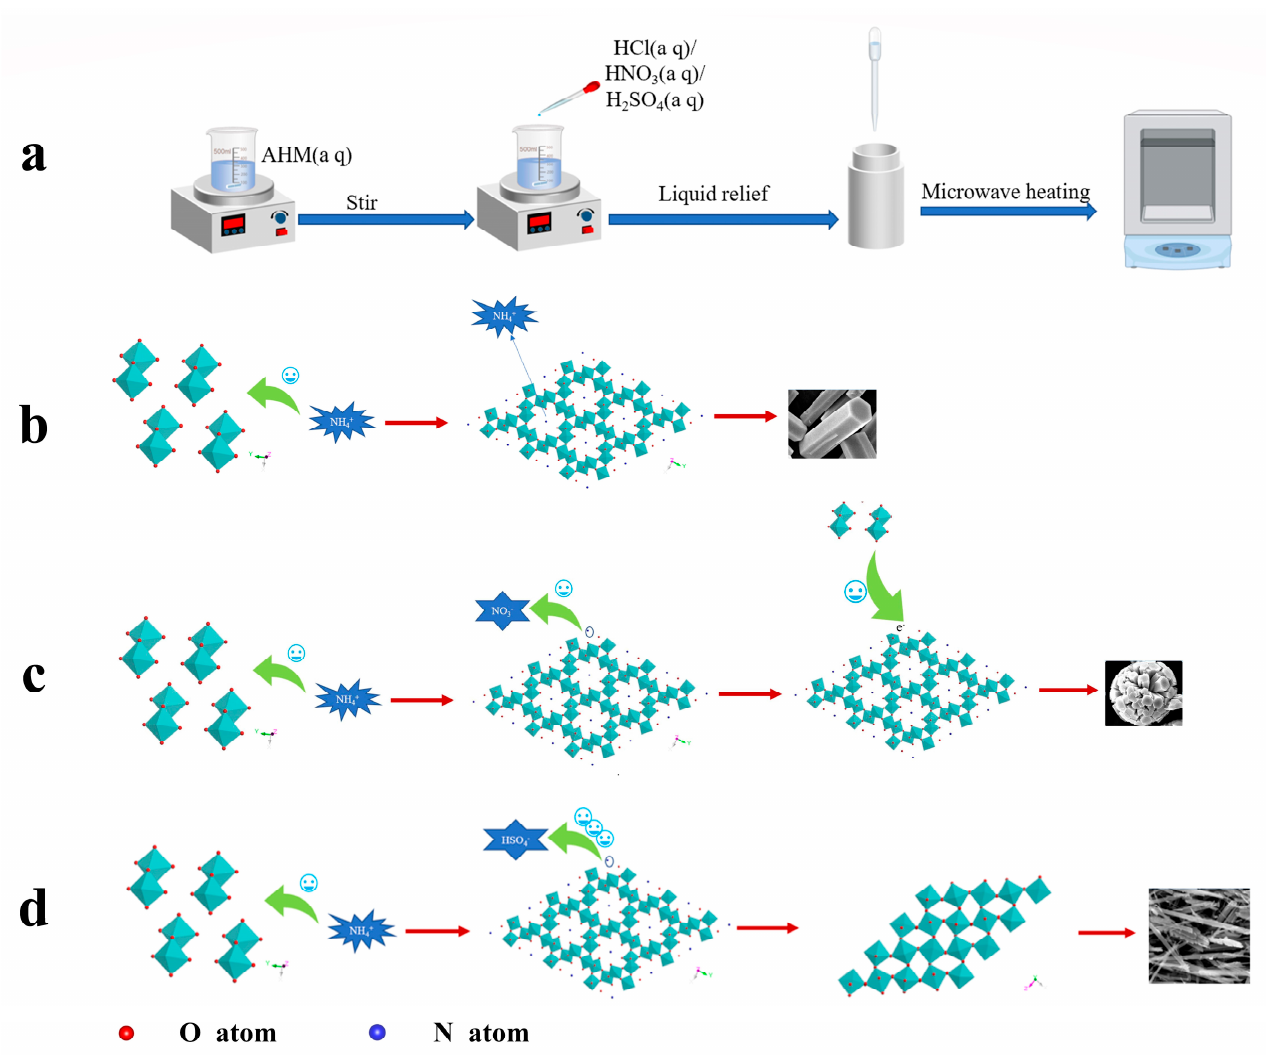
Figure 6. Schematic diagram of MoO 3 growth mechanism: ( a ) flow chart of the experiment, ( b ) the formation mechanism of hexagonal prism h-MoO 3, ( c ) the formation mechanism of spherical h-MoO3, ( d ) the formation mechanism of fi brous α -MoO 3.